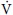
Association between the decline in CO2 production and the increase in dead space.The mean annual changes in peak V˙
co
2 (ΔpV˙
co
2) were significantly correlated with those in the dead space fractions (ΔV˙
d/V˙
t) (p<0.0001, r = -0.589).